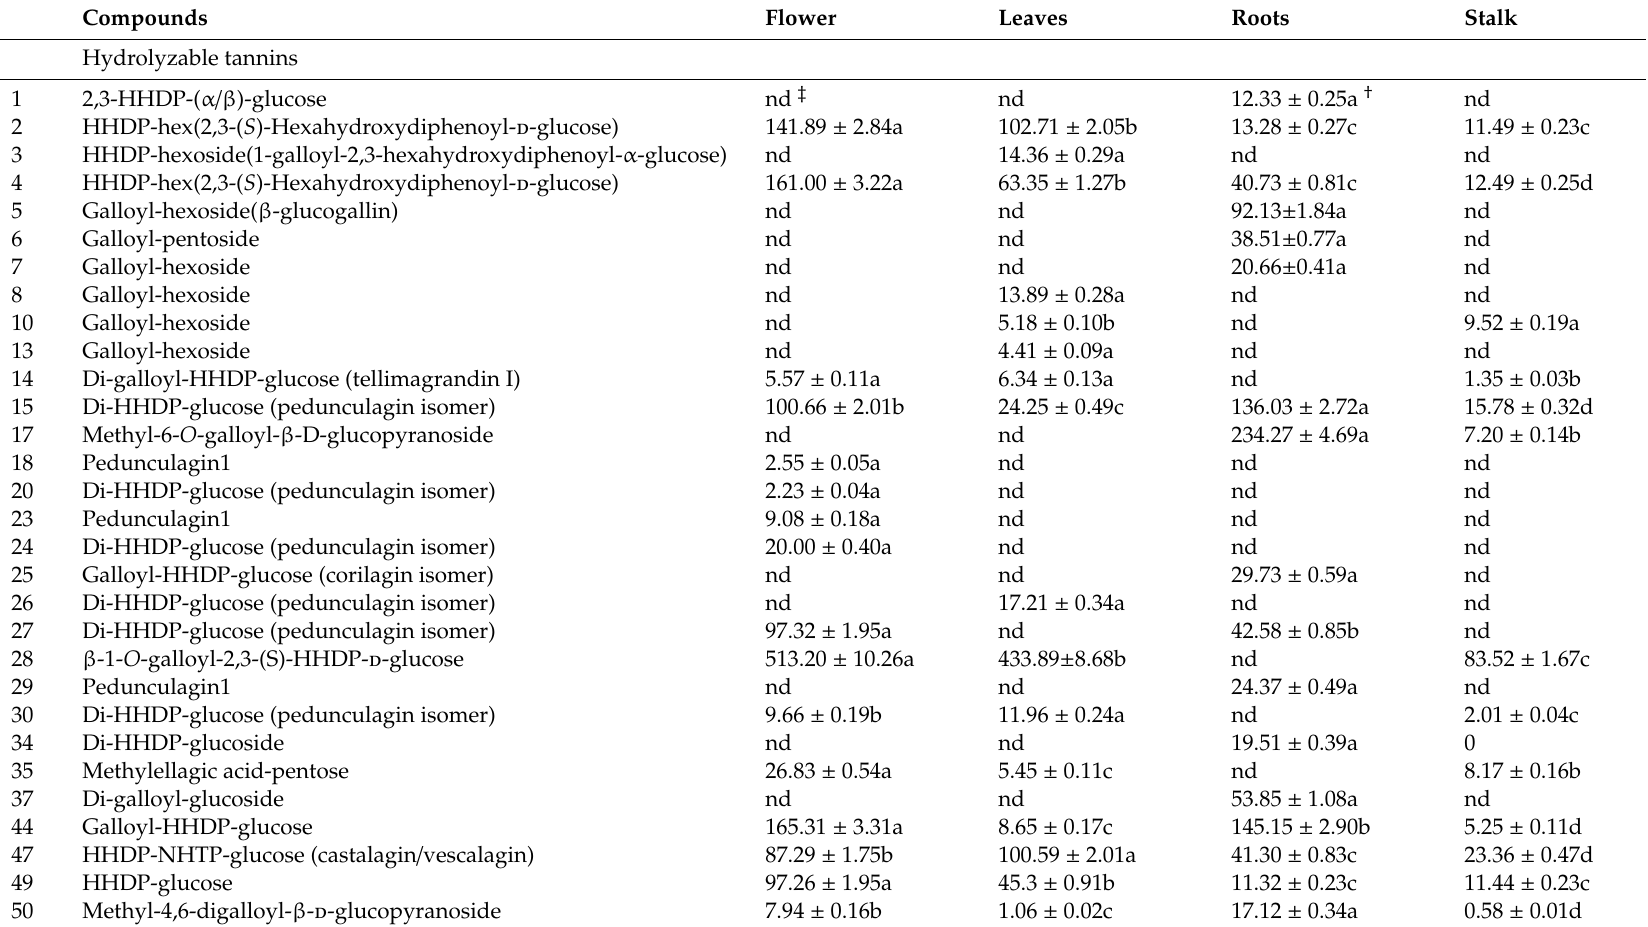
Table 2. Content of polyphenolic compounds in Sanguisorba o ffi cinalis [mg / 100 g d.w.]. Compounds Flower Leaves Roots